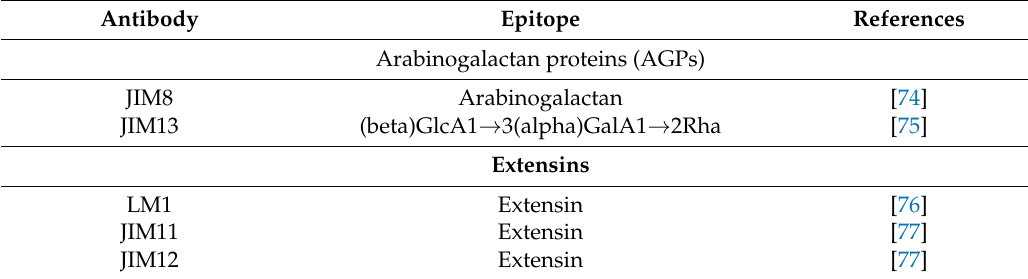
Table 2. Antibodies used for immunocytochemistry, the epitopes they recognize, and relevant references.